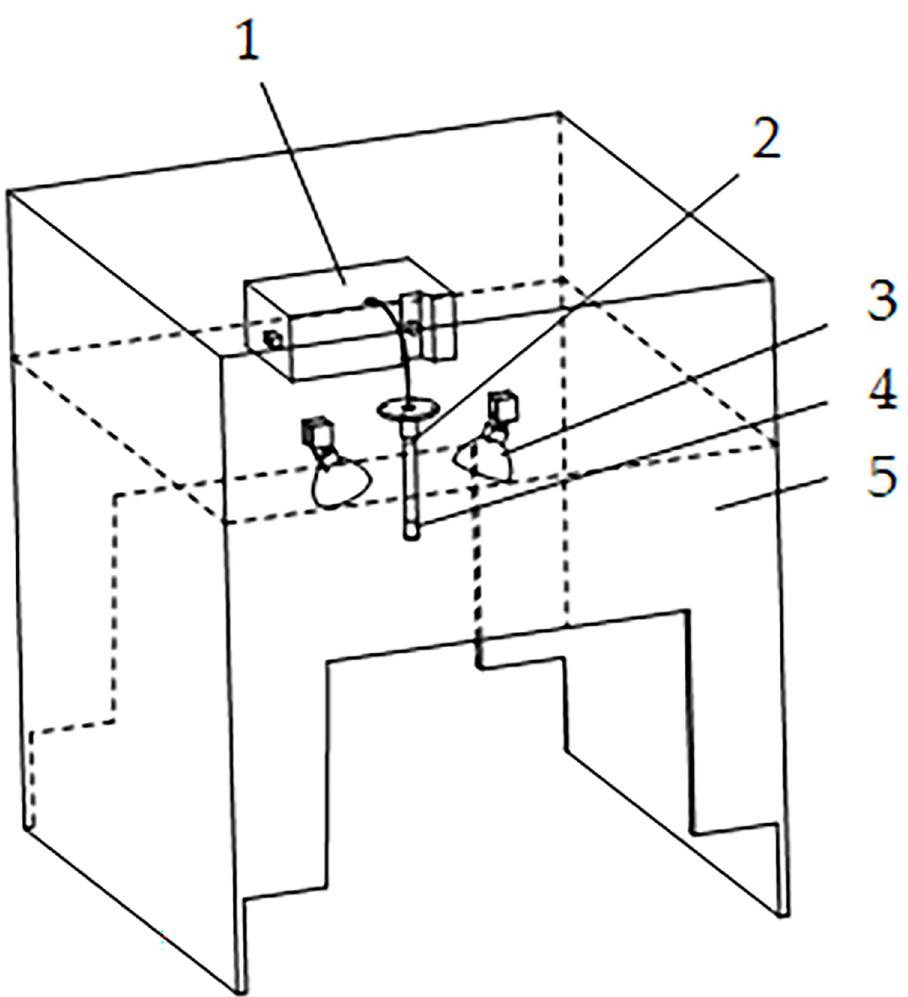
Fig 9. Sketch of the structure of the apple internal quality detection device. 1- Spectrometer 2- Fiber optic probe 3- Tungsten-halogen light source 4- Focusing lens 5- Dark box housing.